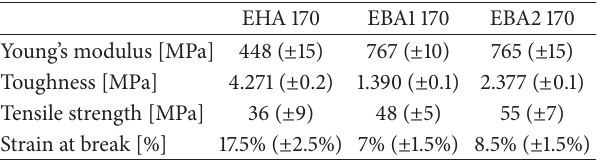
Table 1: Tensile properties of EHA, EBA1, and EBA2 at 170 ∘ C. EHA 170 EBA1 170 EBA2 170 Young’s modulus [MPa] 448 ( ±